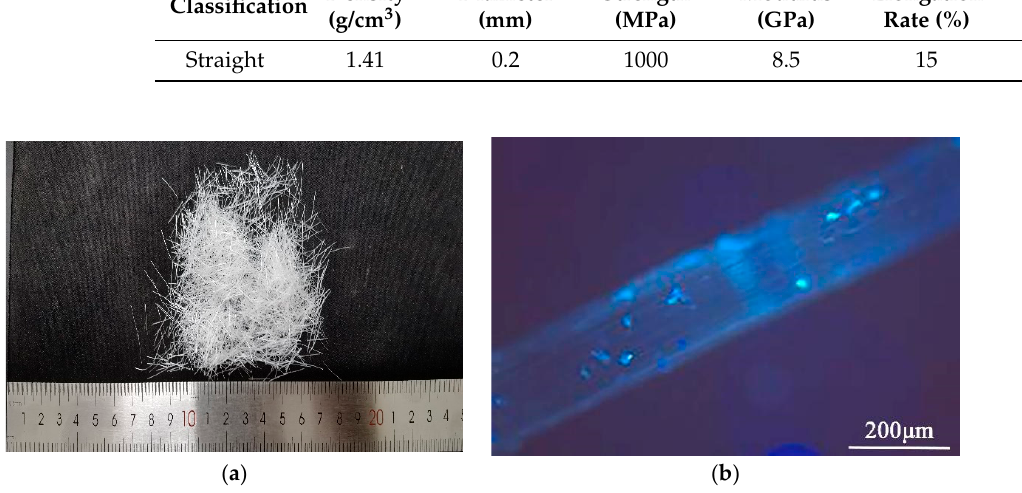
Figure 1. ( a ) Macro and ( b ) micro morphologies of POM fibers. Table 2. Physical and mechanical properties of POM fiber.